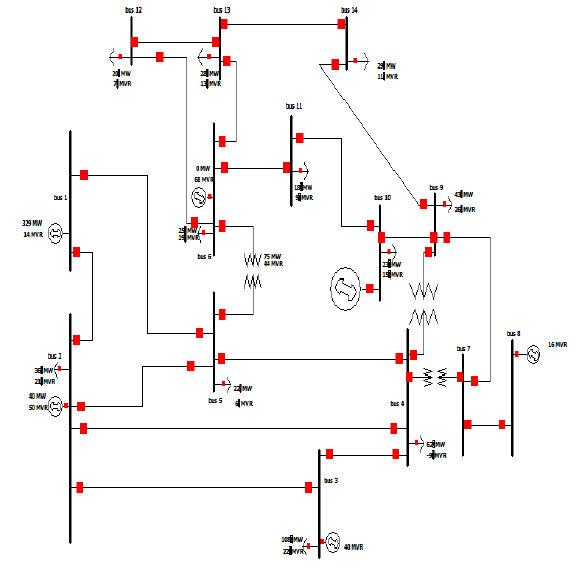
Fig 2. Distributed source added at bus no. 10